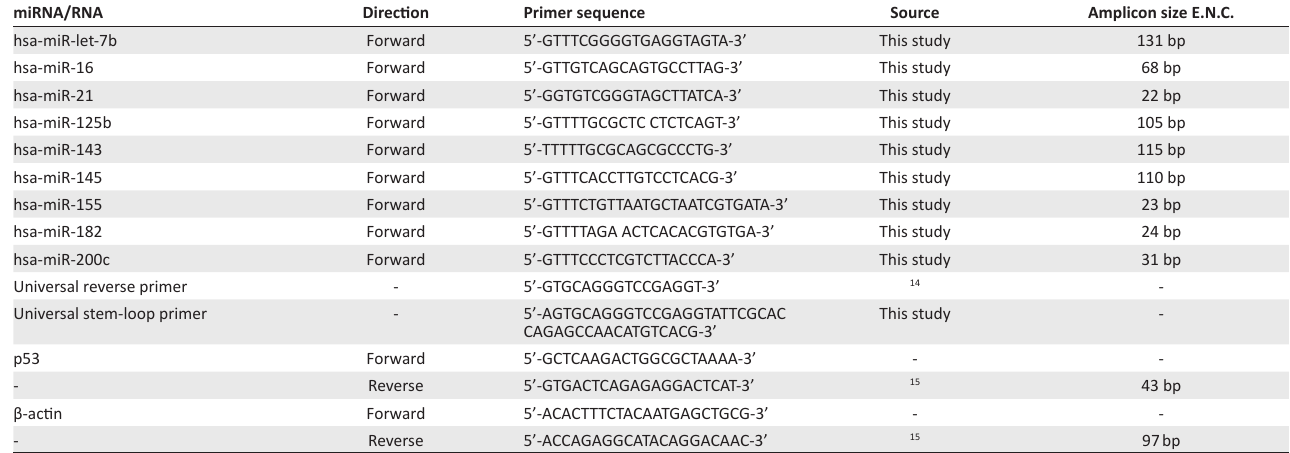
TABLE 1: List of primer sequences.